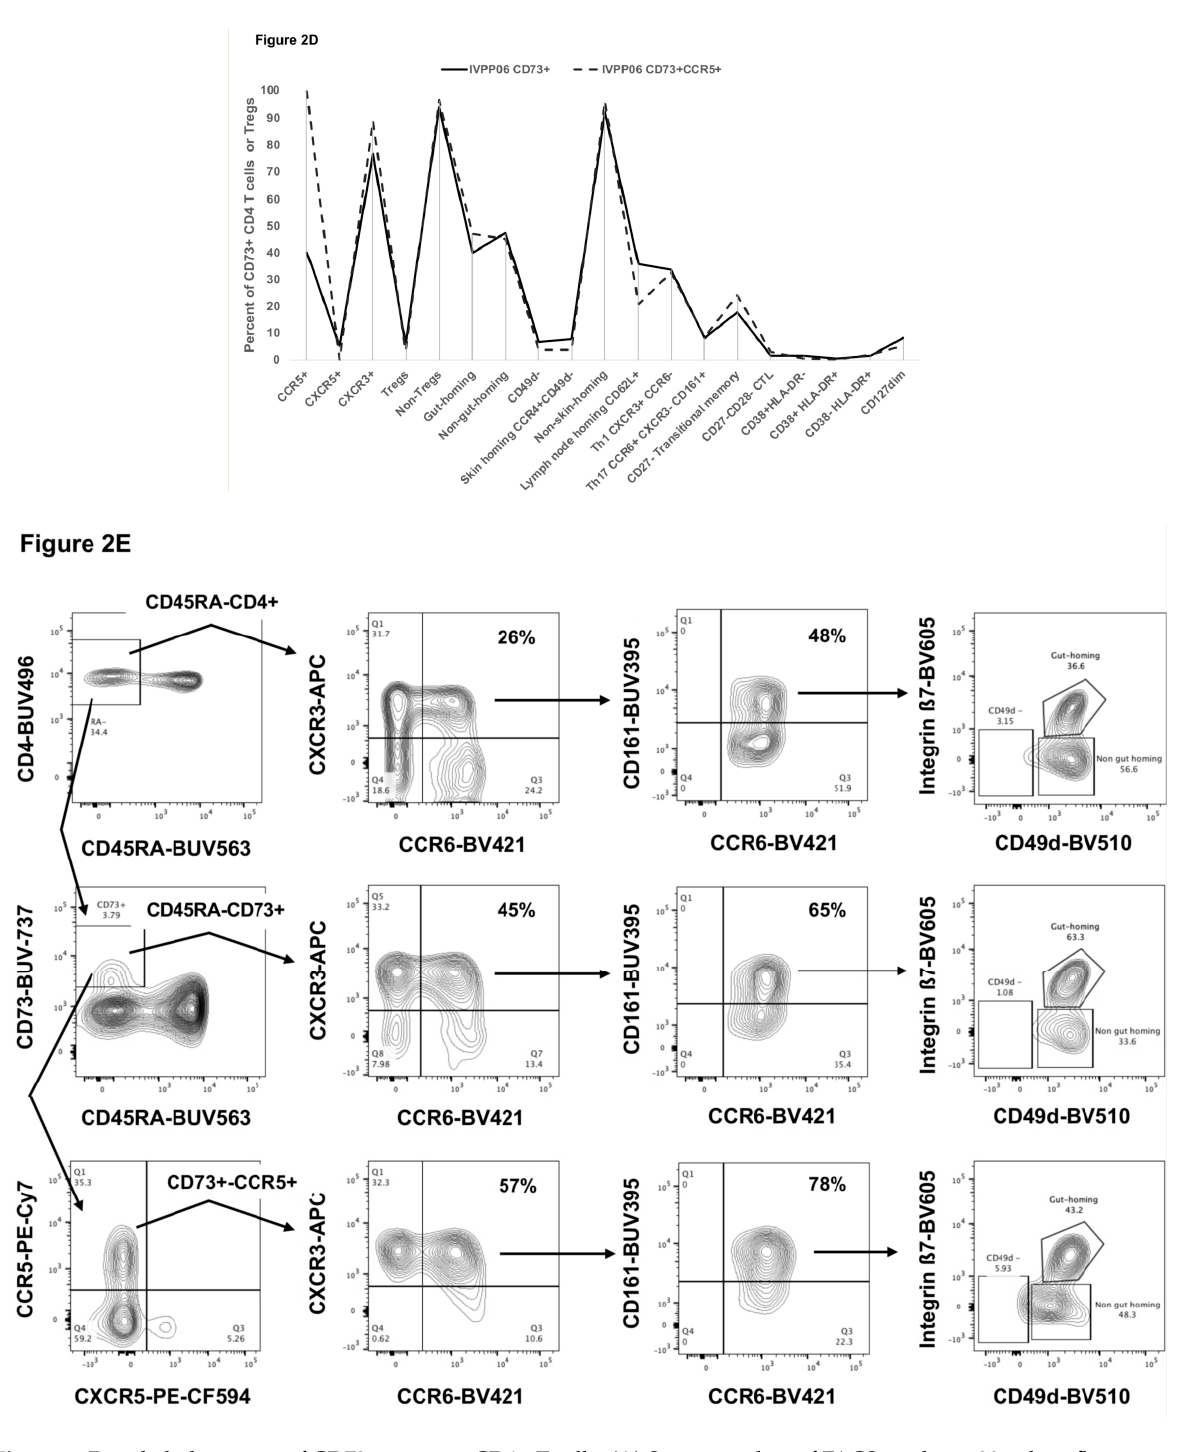
Figure 2. Detailed phenotype of CD73+ memory CD4+ T cells. ( A ) Summary data of FACSymphony 20-colour fluorescence flow cytometry analysis of CD73+ memory CD4+ T cells for n = 4 healthy adult controls. ( B ) Summary data of CyTOF 39-parameter mass cytometry analysis of CD73+ memory CD4+ T cells for n = 2 healthy adult controls. ( C ) Comparison of 20-colour flow cytometry data for CD73+ CD45RO+ CD4+ T cells versus CD45RO+ Tregs in the same sample shown for one healthy adult control, donor IVPP06. ( D ) Comparison of 20-colour flow cytometry data for CCR5+ CD73+ CD45RO+ CD4+ T cells versus all CD73+ CD45RO+ CD4+ T cells in the same sample from one healthy adult control, donor IVPP06. ( E ) Detailed 20-colour flow cytometry data for the phenotype of CCR5+ CD73+ CD45RO+ CD4+ T cells (lower plots) versus all CD73+ CD45RO+ CD4+ T cells (middle plots), and versus all CD45RO+ CD4+ T cells (upper plots), shown for one donor, IVPP06, from Figure 2A.